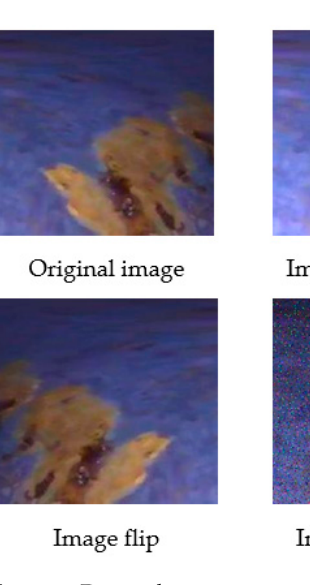
Figure 6. Sample-data presentation.